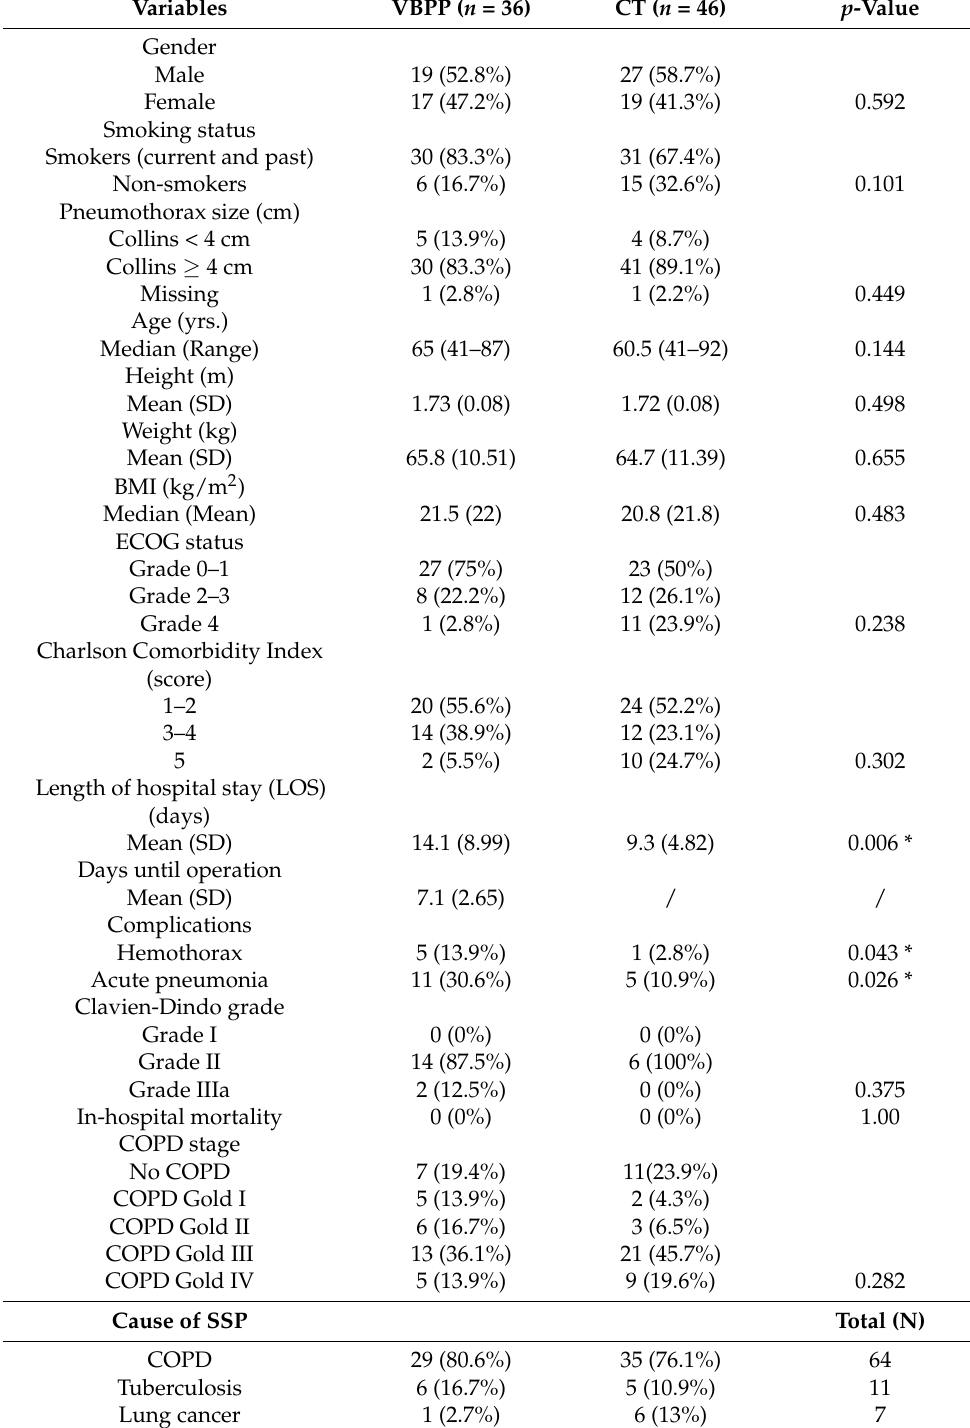
Table 1. Clinical characteristics and cause of SSP of the VBPP and CT